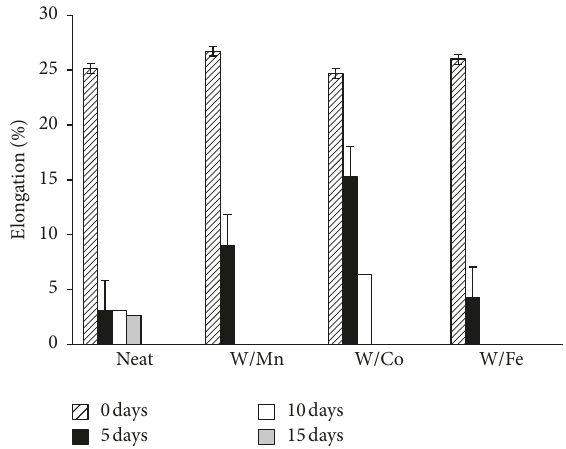
Figure 10: Elongation at break of Topas 6013 COC neat and formulated film with different POA.